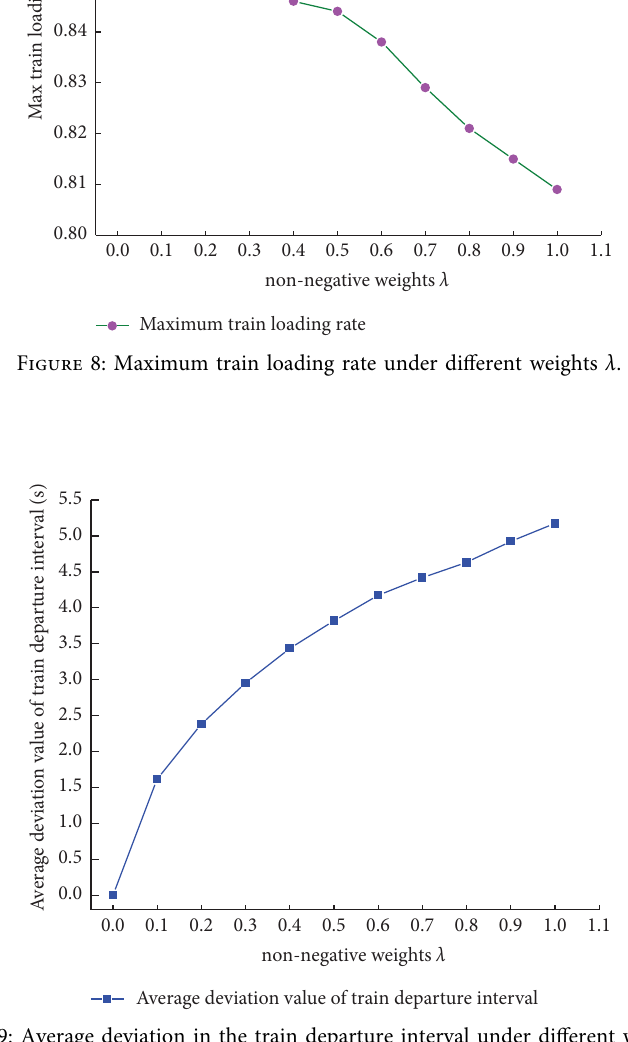
Figure 9: Average deviation in the train departure interval under diferent weights λ .